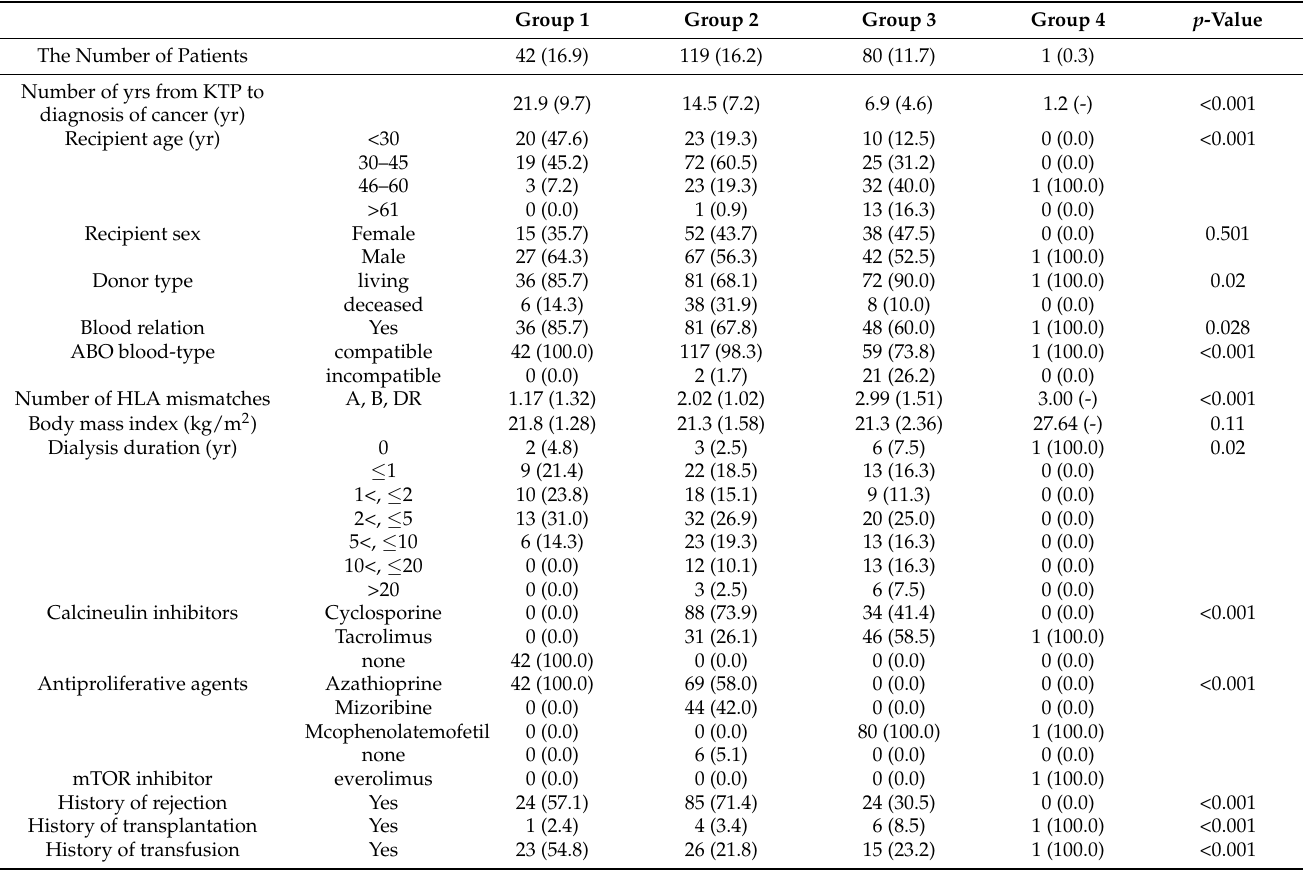
Table 2. Demographic characteristics of transplant recipients with de novo cancers after kidney transplantation. Group